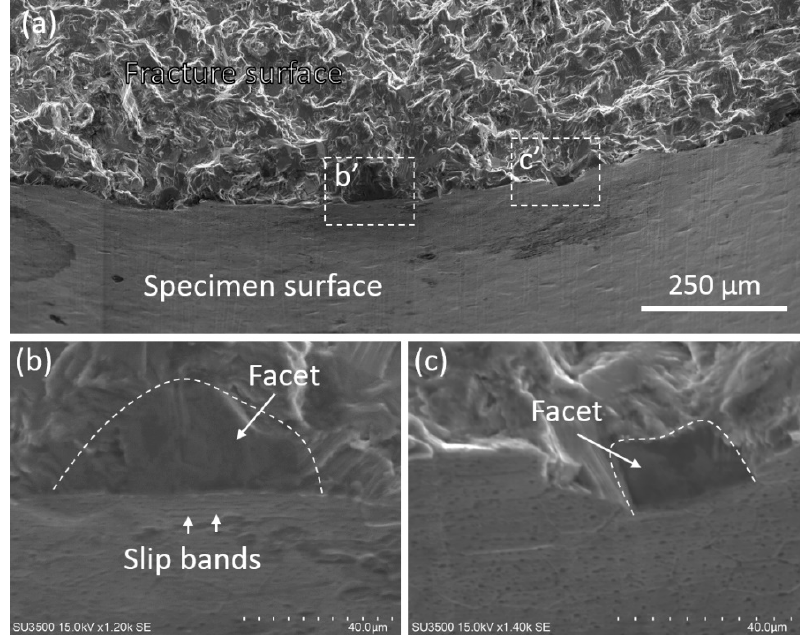
Figure 7. Fracture surface showing the morphology of facet. ( a ) Side view of overall fracture surface; ( b ) and ( c ) facets along fatigue crack path.